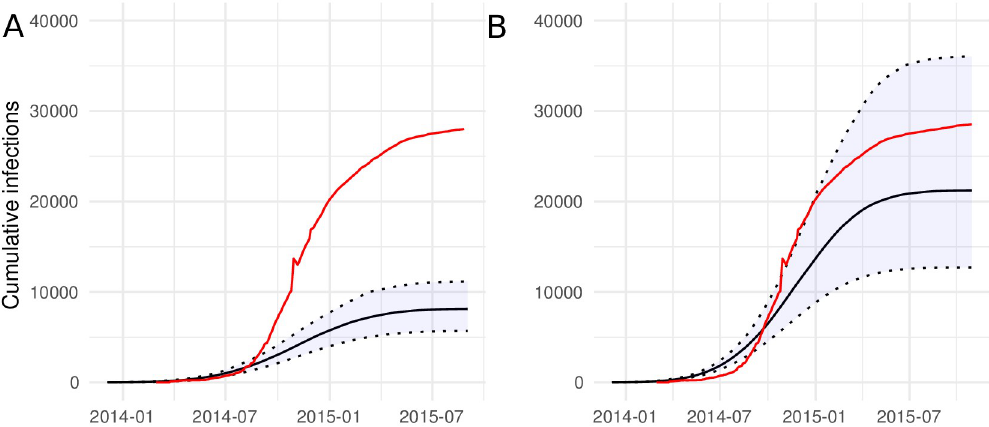
Fig 3. Model-based estimates of cumulative infections through time for the 2014-15 Ebola epidemic in Western Africa. Estimates are shown for the SEIR model (A) and the model which includes super-spreading (B). The red line show the cumulative number of cases reported by WHO